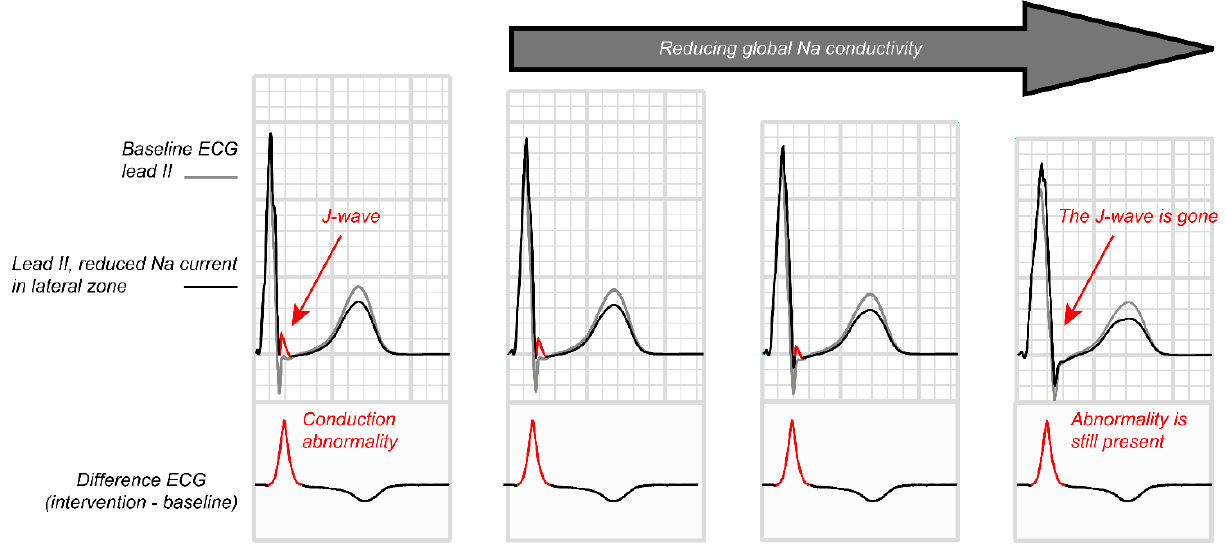
Figure 3. Inferolateral J waves and their attenuation by sodium channel blockers. The effects of reduced Na current, reduced coupling, and increased transient outward current on inferolateral J waves were evaluated with computer simulations using a detailed model of the human heart and torso [44]. Propagating action potentials were simulated with a monodomain reaction-diffusion model. At 1-ms intervals the simulated transmembrane currents were inserted in a torso model and a static bidomain problem was solved to obtain the electrocardiogram (ECG). Global reduction in Na-channel conductivity deformed and prolonged the QRS complex, masking the inferolateral J-waves. Subtraction of the ECGs with and without local intervention showed that the ECG change associated with the local reduction in Na current was not reduced, but was only hidden by the expanding QRS